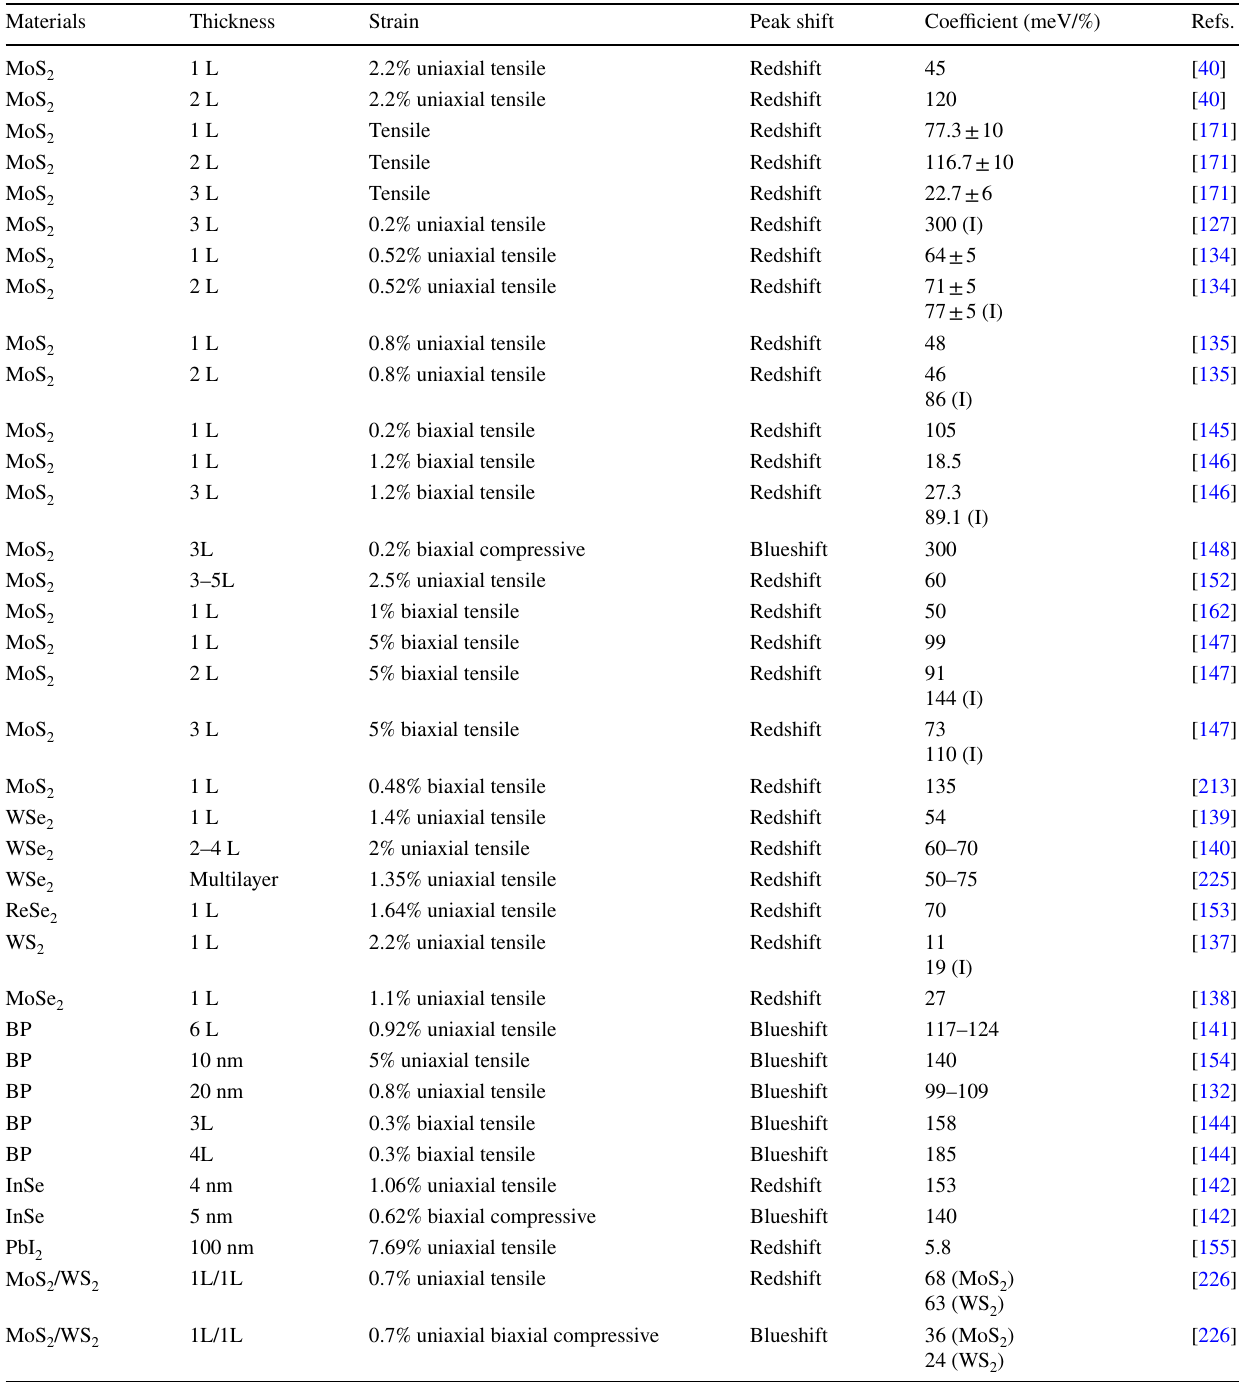
Table 1 Comparison between the different strain experimental results available in the literature for 2D semiconductors Materials Thickness Strain Peak shift